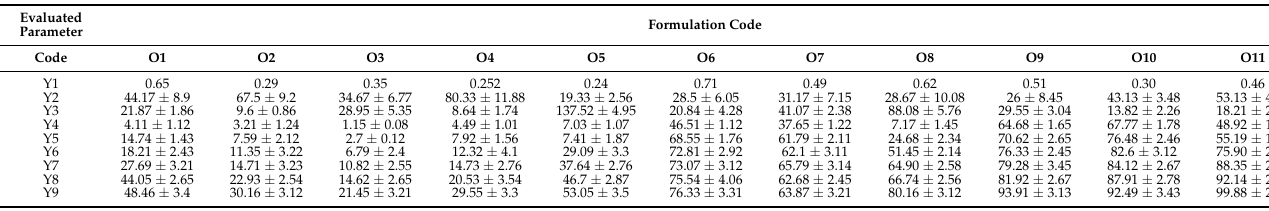
Table 6. The CBD ODTs answers for the dependent